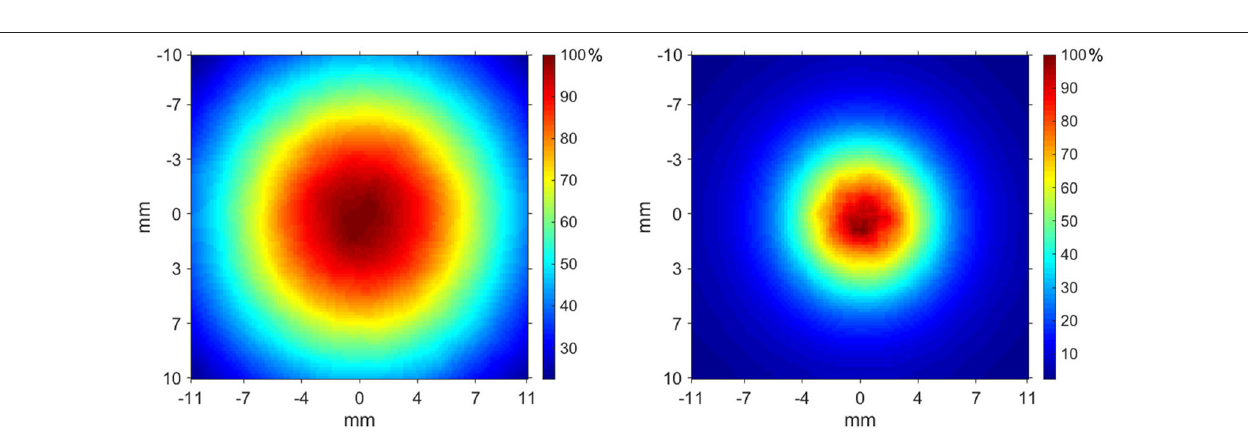
FIGURE 5 | Transverse dose distribution measured at 6mm in Plastic Water ® slabs—FLASH beam 1 (left), FLASH beam 2